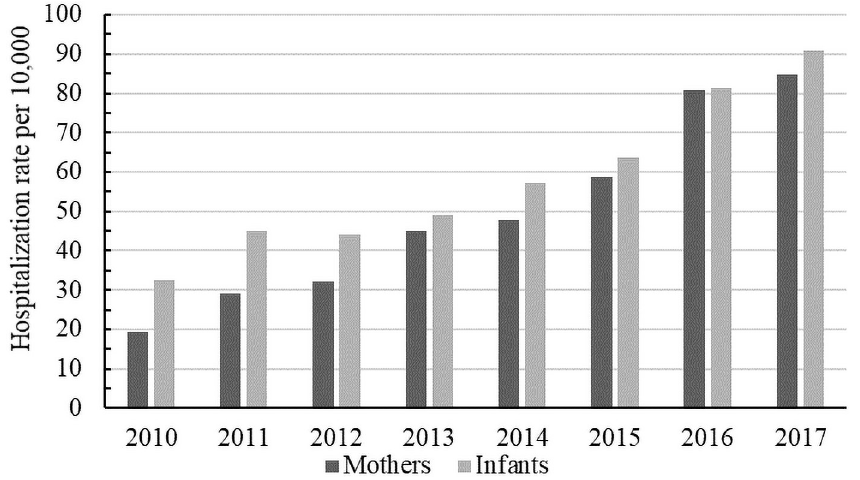
https://doi.org/10.1371/journal.pone.0248476.g001